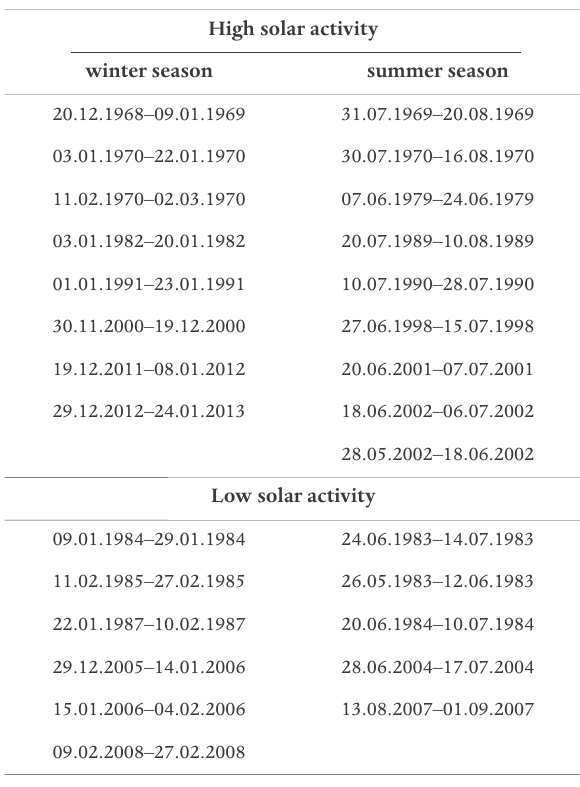
Table 1. Time intervals of foF2 data used for model identification.